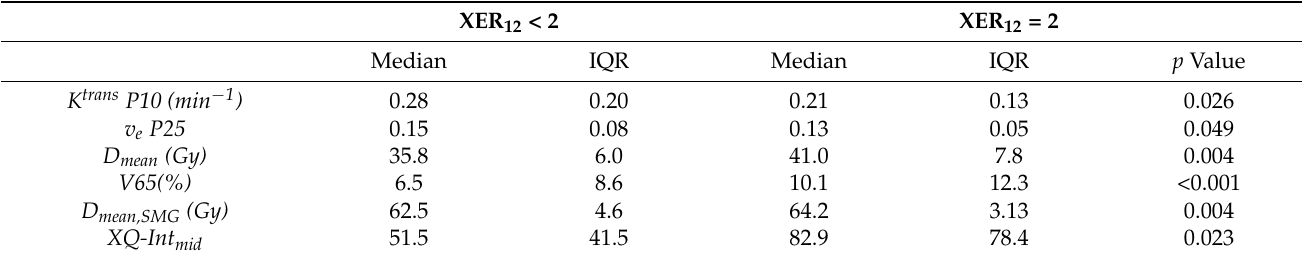
Table 2. Selected predictors for Xerostomia Grade ≥ 2 after 12 months of